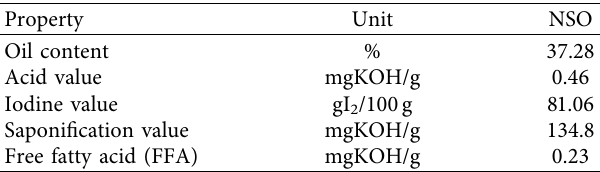
Table 2: Physicochemical properties of